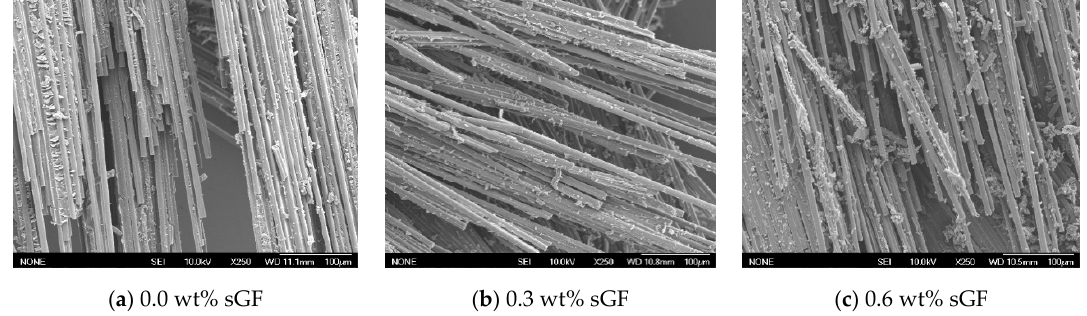
Figure 6. SEM images of fracture surface of 25 mm composites after tensile test.